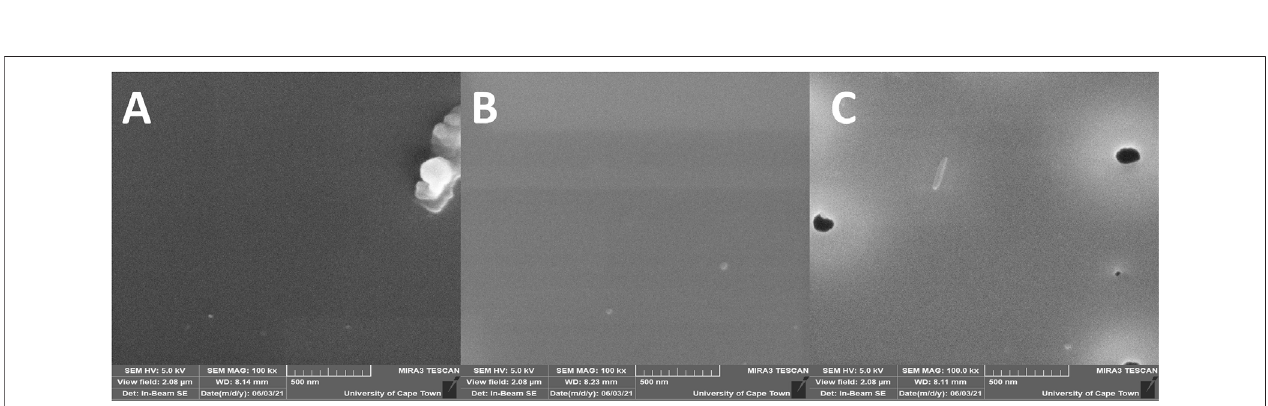
FIGURE 6 | SEM images of HTB-co-P3HT fi lms prepared in (A) chlorobenzene, (B) toluene and (C) chloroform.